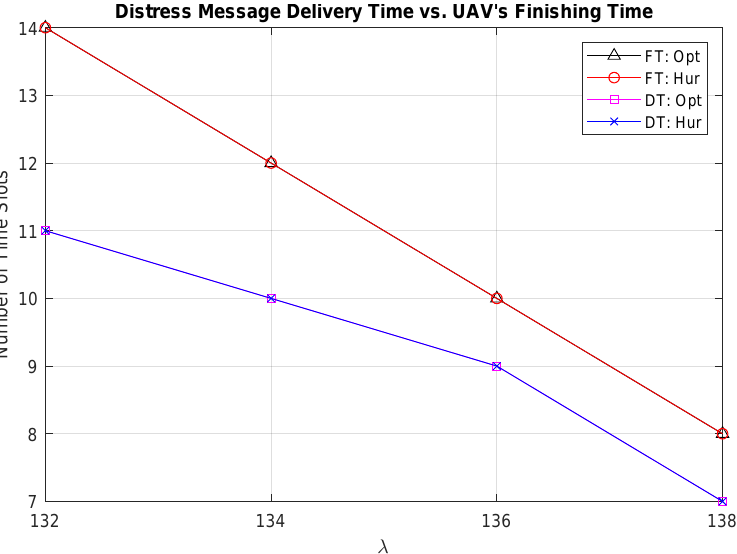
Figure 10. Finishing time vs. delivery time vs. λ